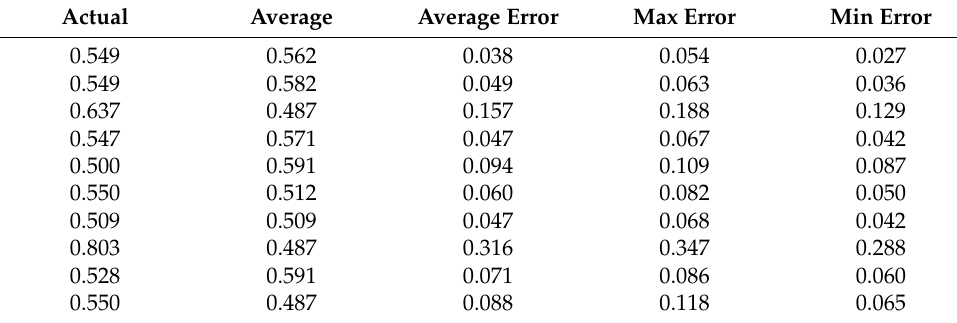
Table A144. Set 2, trials 41–50 data (average actual PR